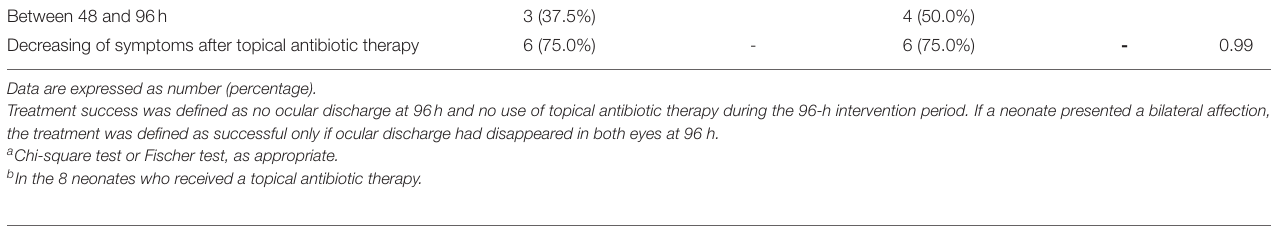
TABLE 5 | Evolution of symptoms in neonates who did not go on to receive a topical antibiotic therapy according to treatment arm ( n = 68 neonates, 87 affected